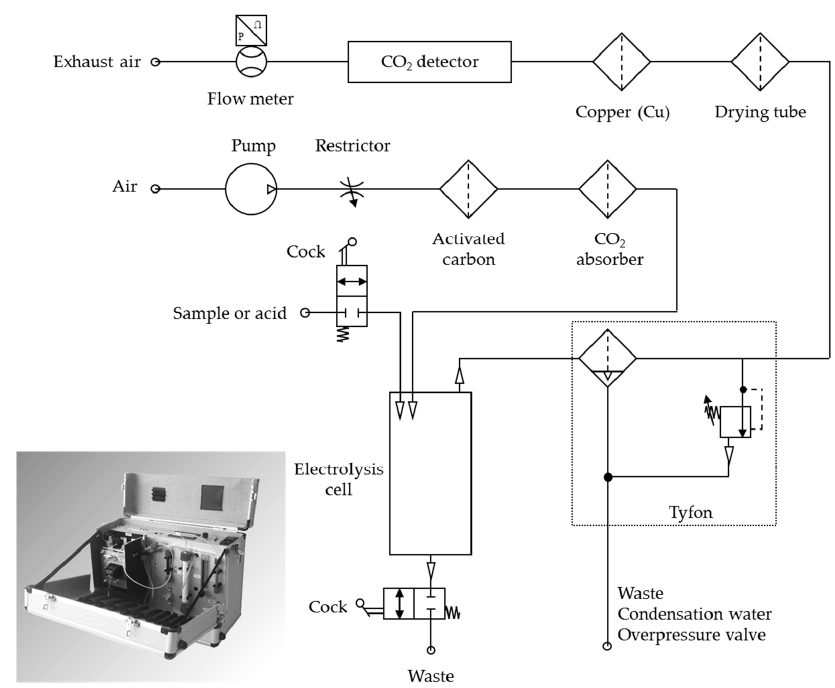
Figure 1. Schematic structure of the portable prototype (DIATOC).